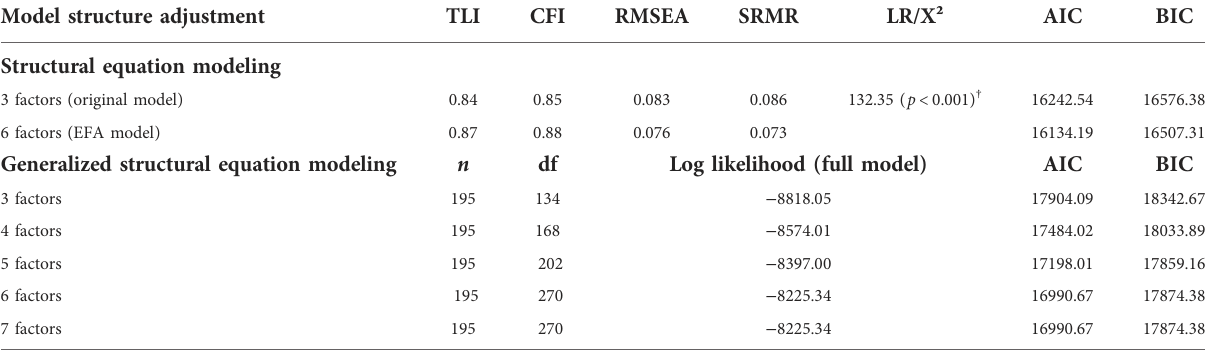
Table 4 Validity analysis (con fi rmatory factor analysis) of the Dutch Eating Behavior Questionnaire (DEBQ). Model structure